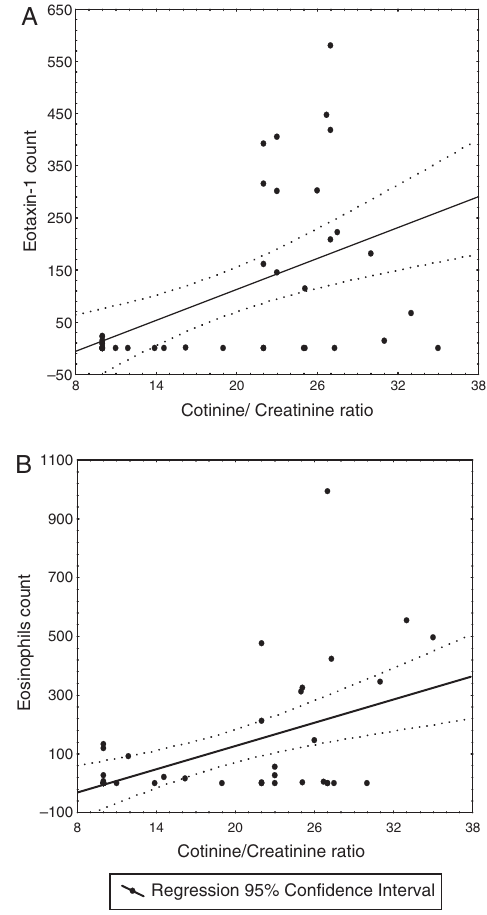
Figure 1 Linear relationship between the urine coti- nine/creatinine ratio and (A) the count of immunoreactive cells to eotaxin-1 and (B) the count of eosinophils, in the nasal mucosa of 44 patients with perennial allergic